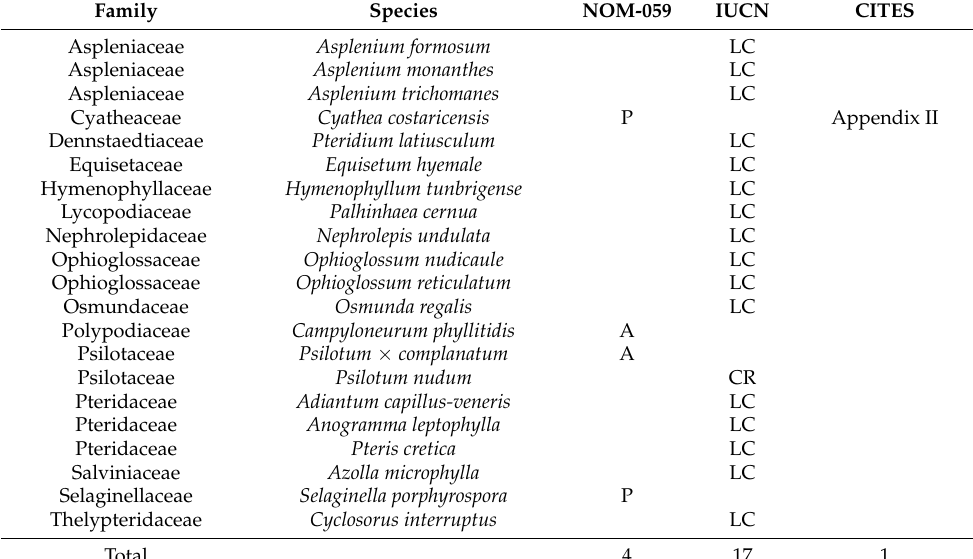
Table 3. Conservation status of the fern and lycophyte species represented in the SMOc and their risk categories in the Mexican Official Norm NOM-059-SEMARNAT-2010, IUCN, and